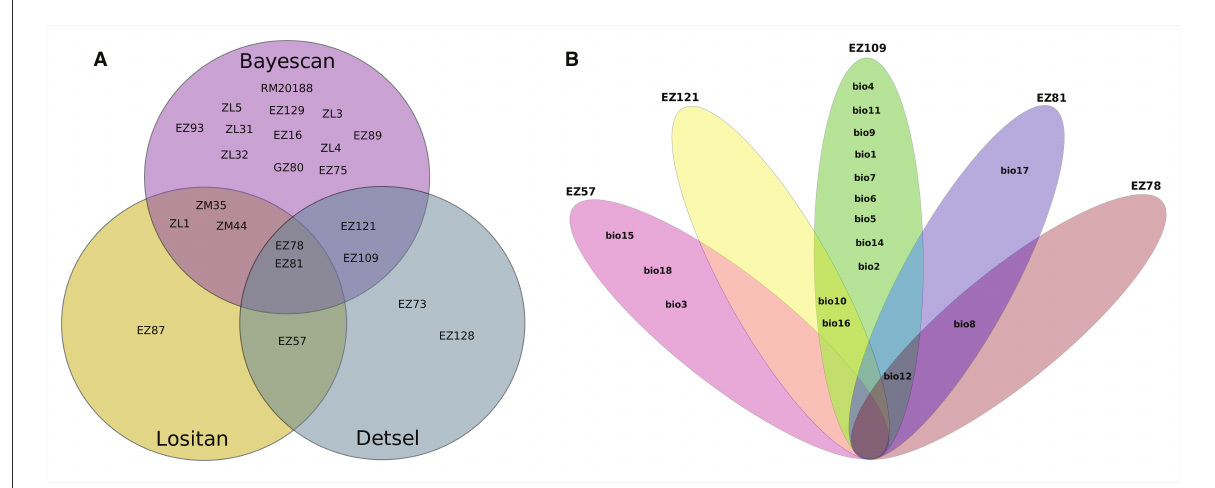
FIGURE1 Summary of outlier loci and allele-environmental variables association. (A) Loci identified by each of the software, between two software and three software, respectively; (B) Environmental variables significantly associated with either of the loci and/or shared among and between